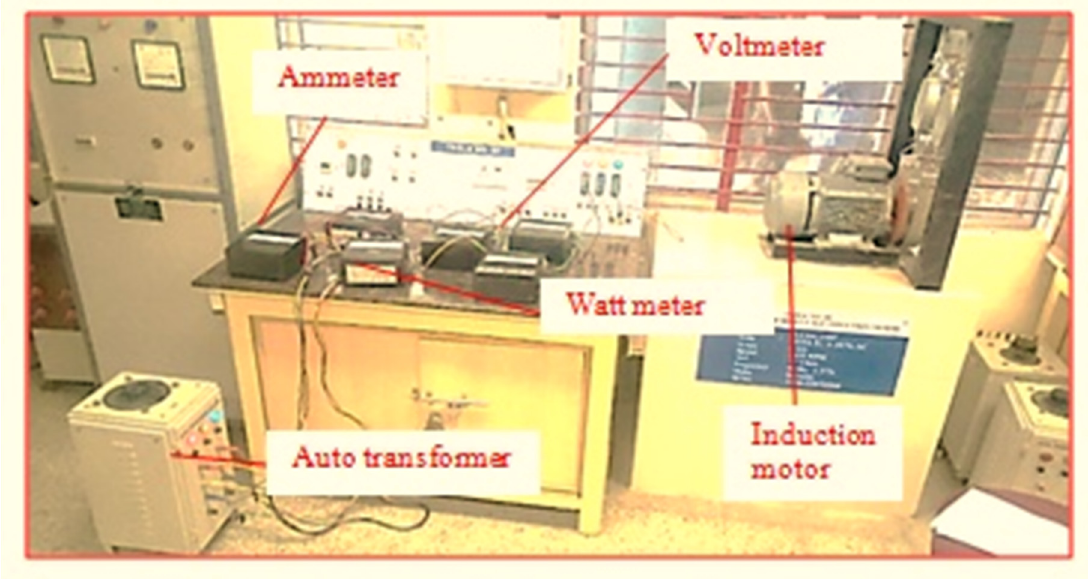
Figure 20. The hardware setup for parameter estimation.